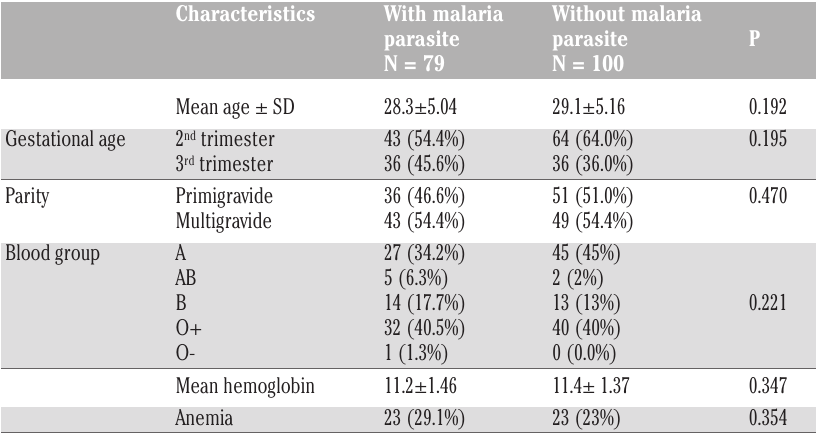
Table 1. Characteristics of the pregnant women with and without submicroscopic P. fal- ciparum infection in Ilorin,